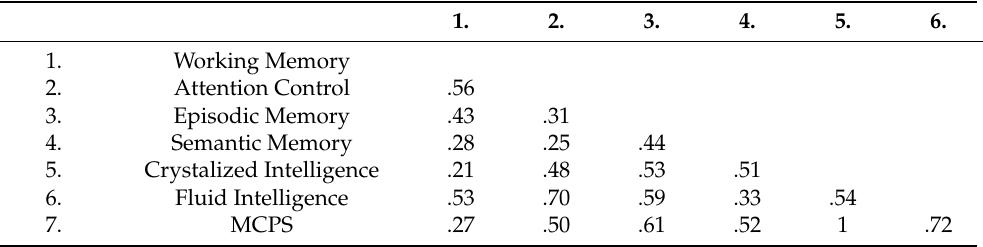
Table 3. Latent factor correlations between cognitive abilities and multiply-constrained problem solving (MCPS).